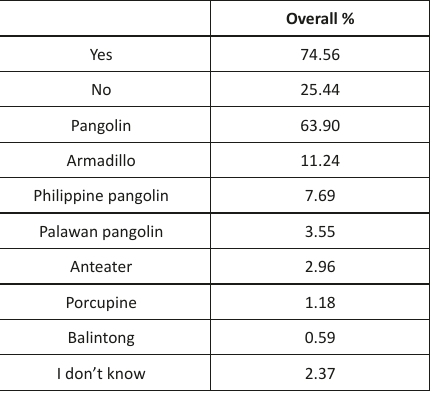
Table 1. Demographic characteristics of respondents (n=169). Table 2. Respondents’ answers to whether they know the animal in the photo or not (N=169).